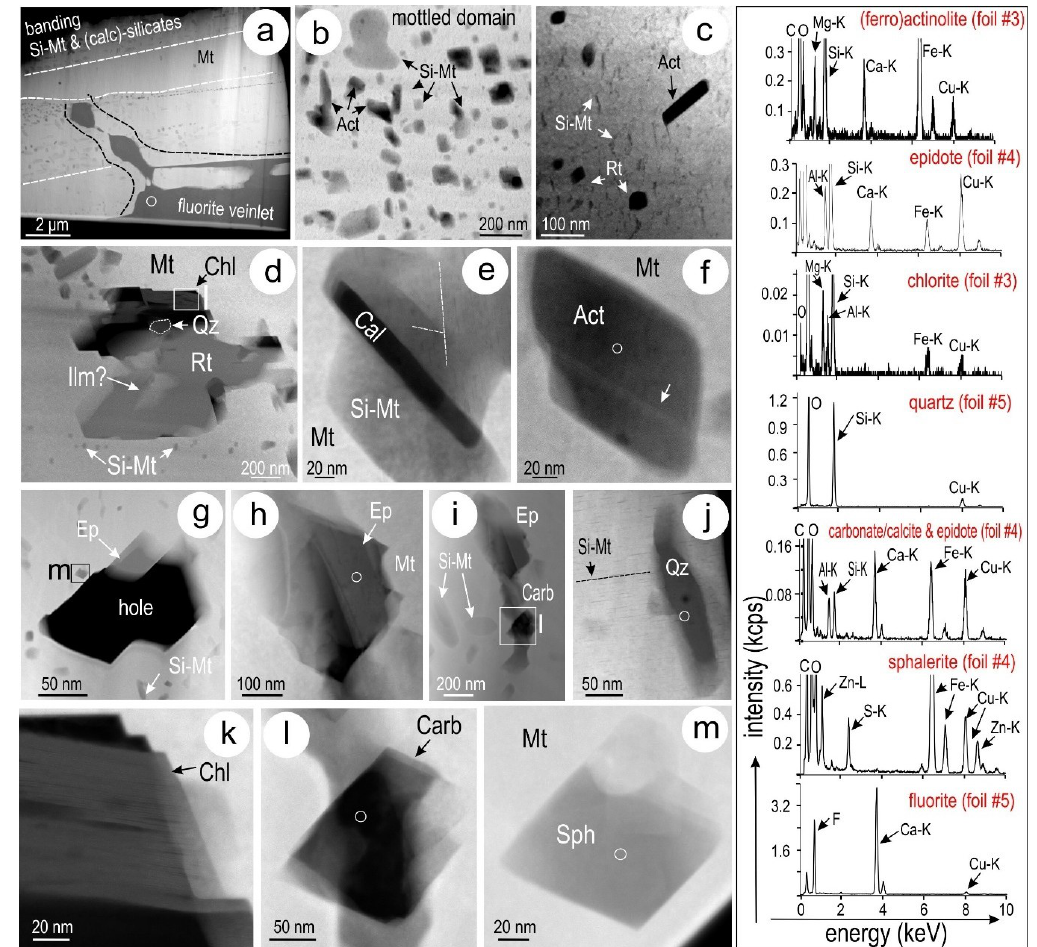
Figure 14. HAADF STEM images ( a – m ) and STEM-EDS spectra (to the right; as marked) showing mineral inclusions in silician magnetite from the eastern transect (foils #3–5). Textures in silician magnetite displaying banding and overprint by vein fluorite in (a), mottled blebs with actinolite (Act) and Si-Fe-nanoprecipitates (Si–Mt) in (b), and difference in sizes and orientation between Act and Si-Mt in (c). (d) complex assemblage in one of the coarsest inclusion clots (foil #3) showing an eclectic assemblage with rutile (Rt), ilmenite (?, Ilm), chlorite (Chl), quartz (Qz) indicative of inherited associations from a precursor magnetite of magmatic origin (?). (e) Coarser Si–Mt bleb with a rod of calcite (Cal). (f) One of the largest Act inclusions with internal zoning most likely due to Fe/Mg variation. Note the inclusions is not associated with Si–Fe-nanoprecipitates. (g–i) Composite associations of epidote and carbonates along arrays of Si-Mt. The hole in (g) is produced by FIB milling. (j) One of the coarsest SiO 2 inclusions superimposed by strips of Si-Mt (dashed line). It is not clear if these are amorphous or crystalline (Qz), could not obtain reliable SAEDs from these inclusions. (k–m) Close-up images showing details of some of the rarer inclusions. Note the layered structure of Chl in (k), the rhombus-like shape of carbonate (Carb) and sphalerite in (l) and (m), respectively. The Cu signal on the spectra is from the TEM grids. In the massive magnetite, the distribution, speciation and size of inclusions vary in the same sample (polished block) depending on the grain size of the host magnetite (Figure 13a–c). The NPs are very rare in the coarsest grains (Figure 13a) but are relatively abundant along trails crosscutting crystal zoning in the medium-sized grains (Figure 13c). The few U-NPs found among the Si-Fe- nanoprecipitates defining the crystal zoning in the coarsest grains occur as single blebs with spherical or lobate shapes and are typically embedded within the Si-Fe-nanoprecipitates (Figure 13d–f). In